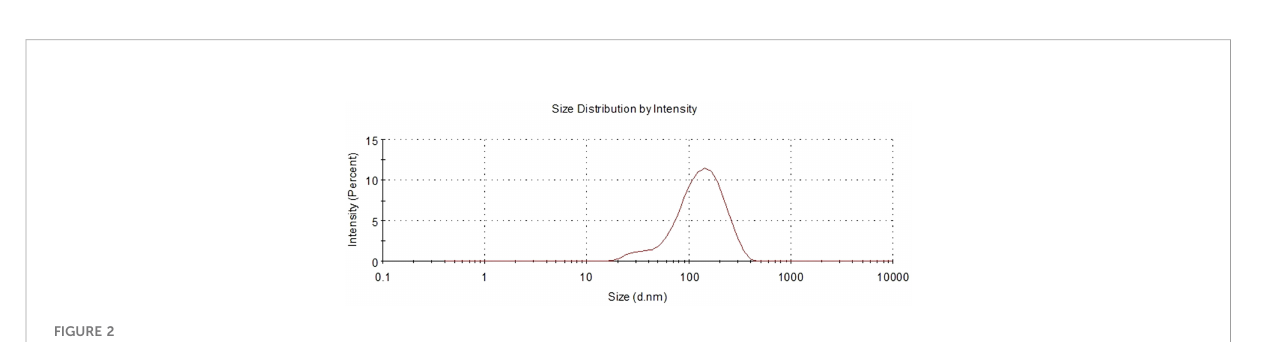
FIGURE 2 Size distribution of well-imaged UCAs measured by dynamic light scattering.